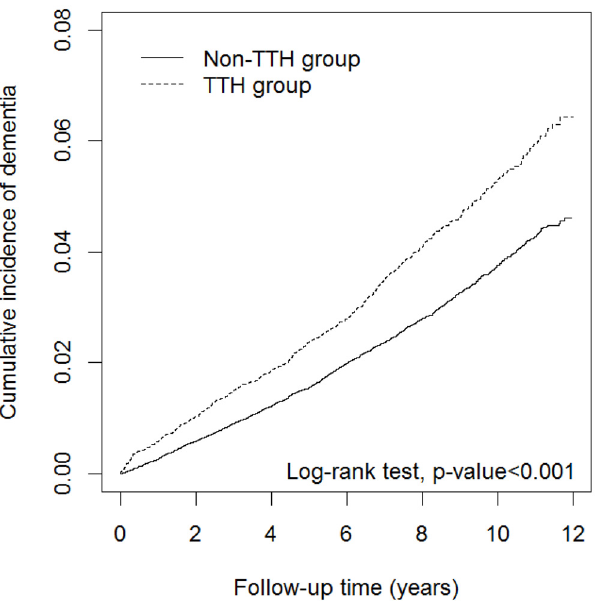
Fig 1. Cumulative incidence curves of dementia for groups with and without tension-type